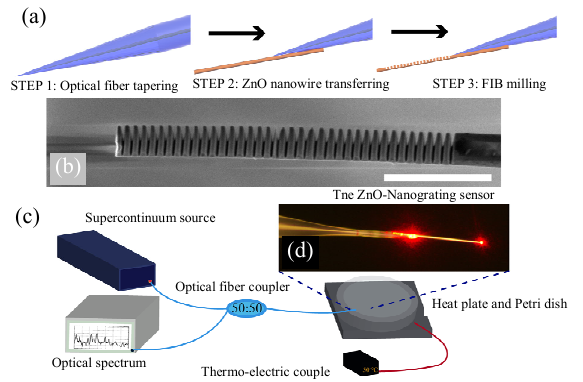
Fig. 3 Schematic diagrams of fabrication process and test of ZnO-nanograting sensor: (a) fabrication process, (b) SEM image (scale bar: 3 μm), (c) schematic for the experiment of ZnO-nanograting sensor, and (d) the microscope image of ZnO-nanograting sensor.